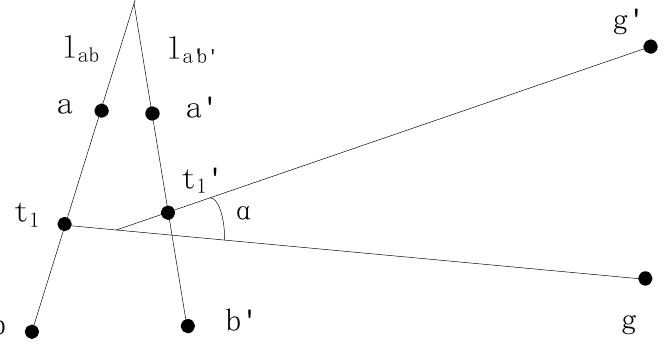
Figure 2. Diagram of Image point